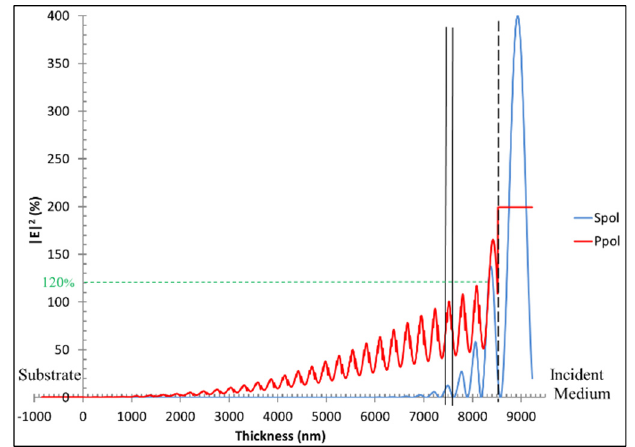
Figure 8. Optical E-field intensities (as % of incident intensity) within the coating for 1000 nm wavelength light at 45° AOI, Spol and Ppol, for the BBHR coating design. The vertical dashed line indicates the boundary of the coating with the incident medium. The two vertical solid lines indicate a TiO 2 coating layer. This figure appeared as the bottom left ‐ hand graph in Figures 6 and 8 of our earlier report [15].